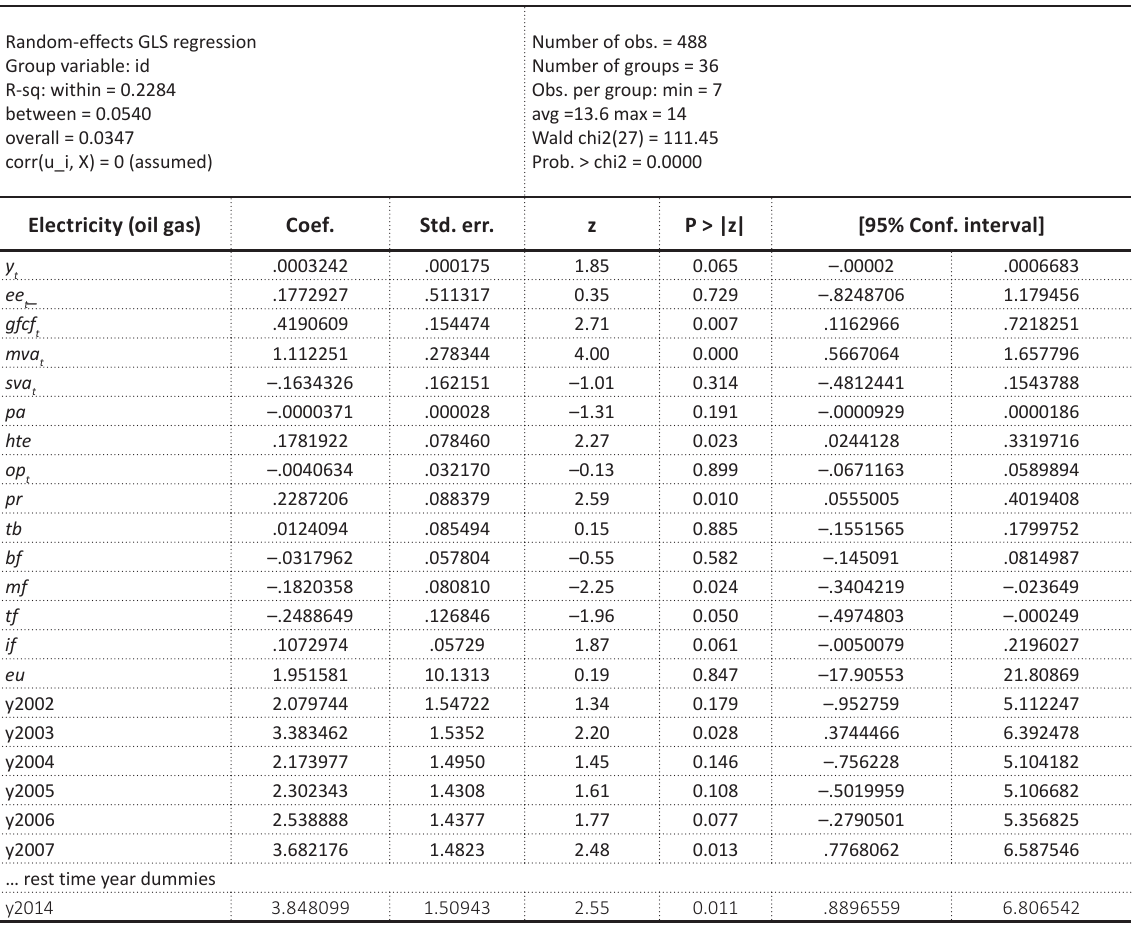
Number of obs. = 488 Number of groups =